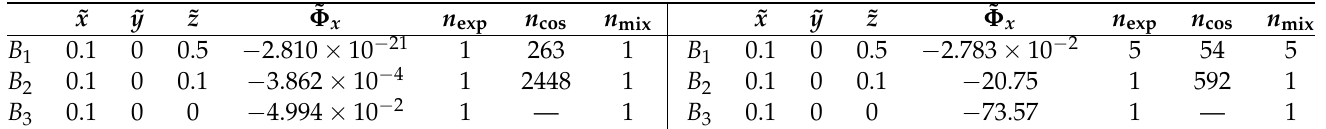
Table 3. Numerical values of the x -component of the rescaled force ˜ Φ x ≡ ∂ ˜ Φ / ∂ ˜ x as well as the numbers n exp , n cos and n mix for points B 1 , B 2 and B 3 for ˜ λ eff = 0.01 and ˜ λ eff = 0.1 in the left and right tables, respectively.